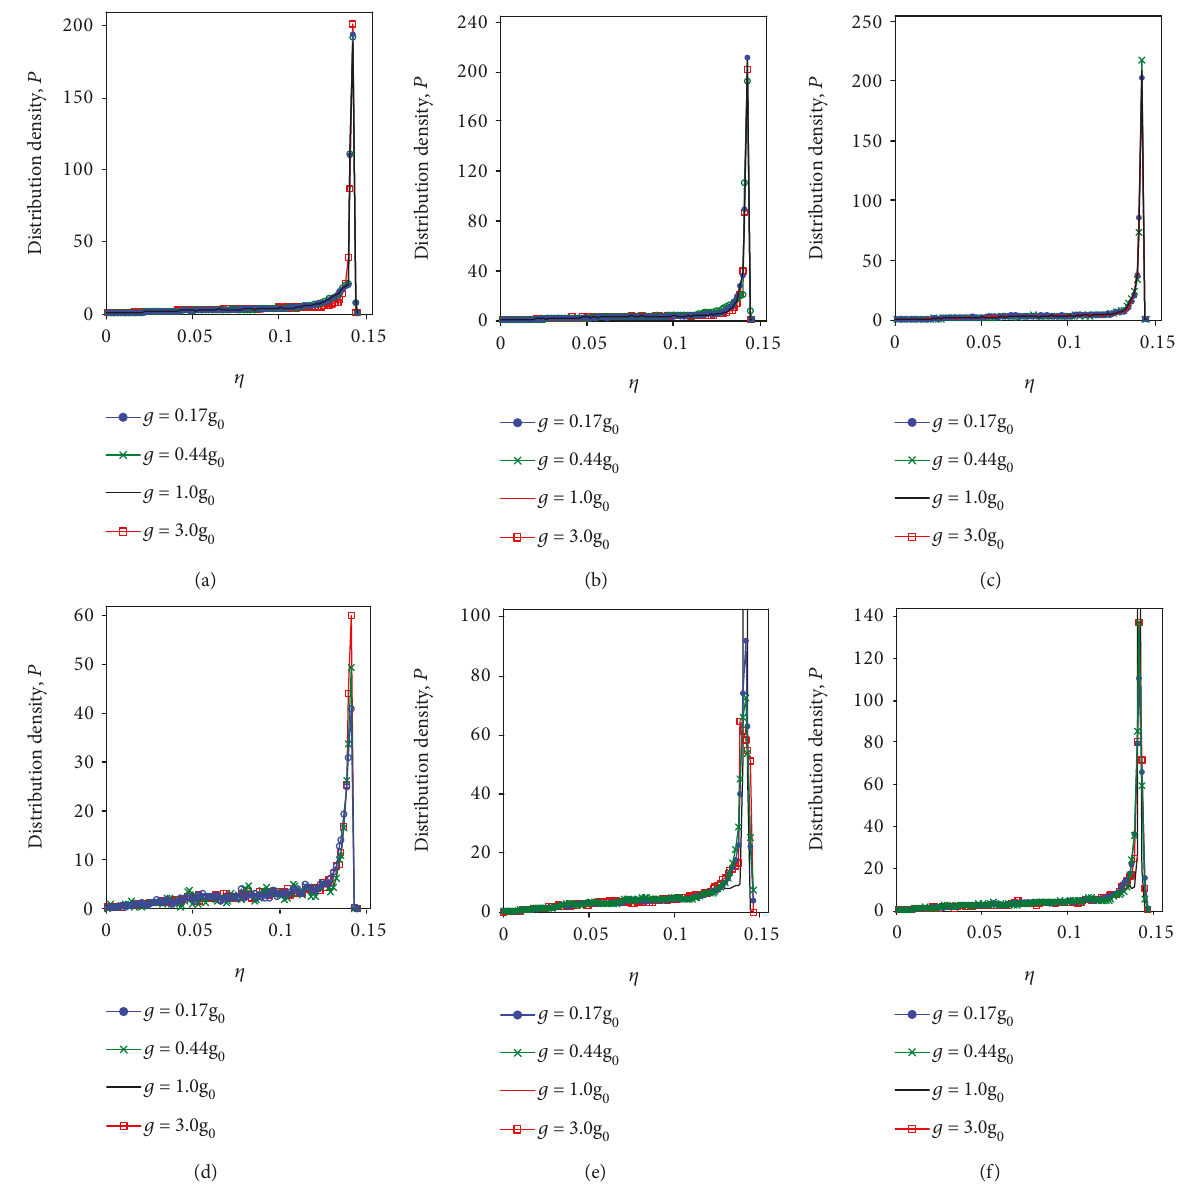
Figure 8: Probability distributions of η ( η = F